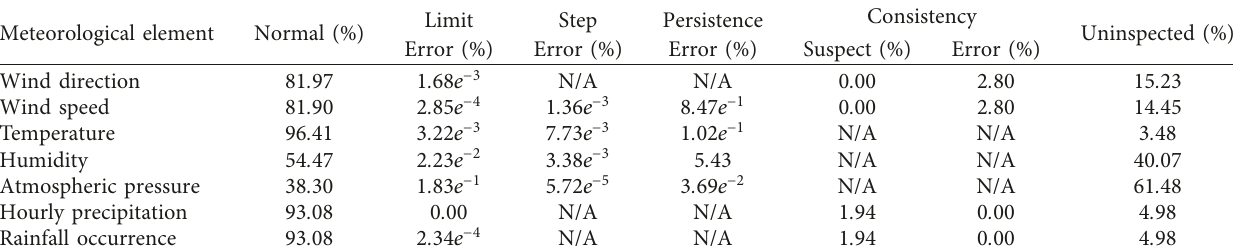
Table 5: Results of basic quality